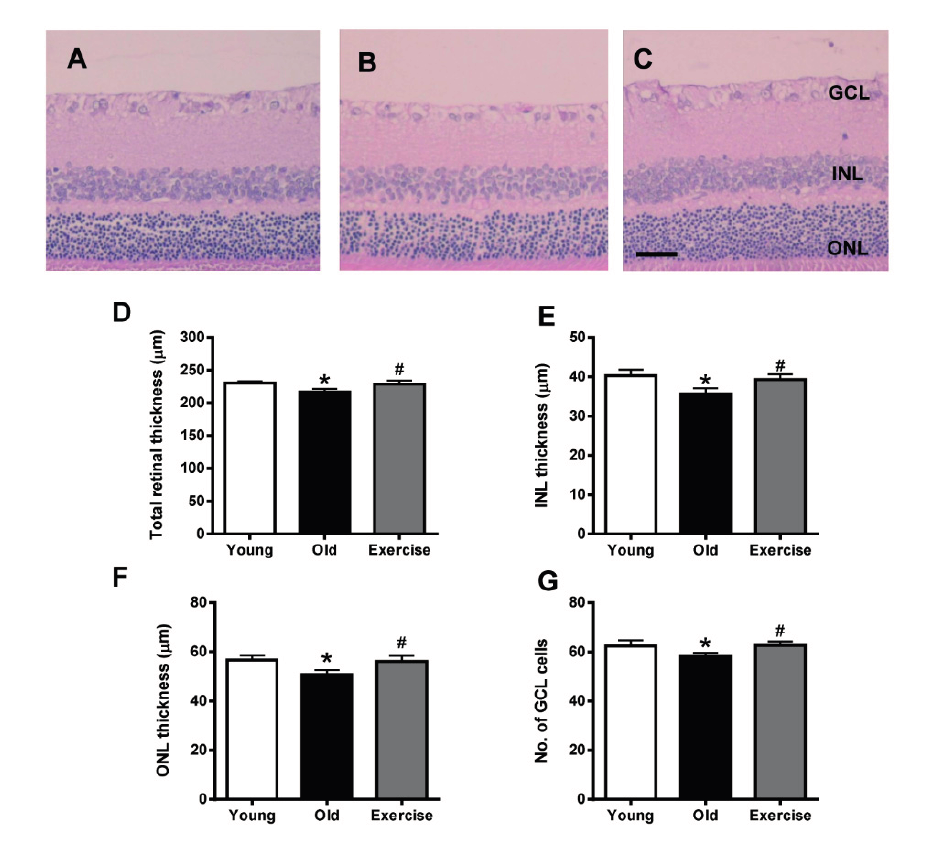
Figure 1. Histopathological retinal changes. Representative retinas from the young control ( A ); old control ( B ); and exercise ( C ) groups were stained with H&E. Retinal thickness of the total retina ( D ); the inner nuclear layer (INL, E ); and the outer nuclear layer (ONL, F ); ( G ) Quantification of the cell loss in the ganglion cell layer (GCL), as assessed by the number of cells in the GCL. The values in the bar graphs represent the means ± SE, n = 8. * p < 0.05 vs . the young control group; # p < 0.05 vs . the old control group. Scale bar = 50 μ